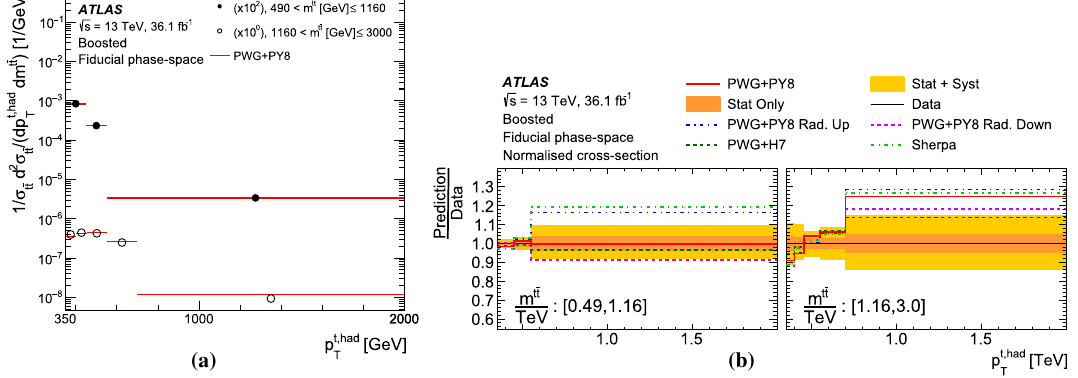
Fig. 45 a Particle-levelnormaliseddifferentialcross-sectionasafunc- tion of p t , had in bins of the absolute value of the rapidity of the hadroni- T callydecayingtopquarkintheboostedtopologycomparedwiththepre- diction obtained with the Powheg + Pythia8 MC generator.Data points